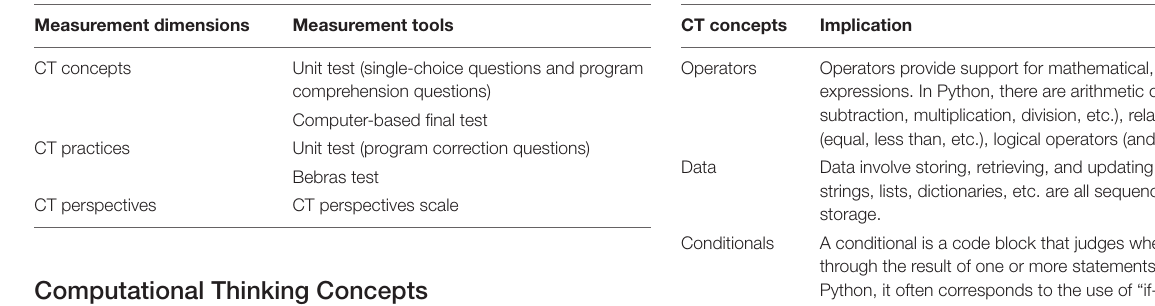
TABLE 4 | Measurement tools. TABLE 5 | Common CT concepts in